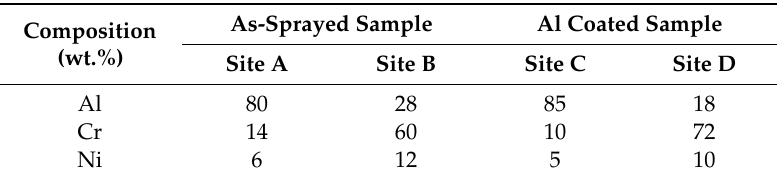
Figure 7. Cross-sectional morphology of bondcoat samples after oxidation for 200 h at 1200 ◦ C ( a ) as-sprayed sample, ( b ) Al coated sample; and EDX spectrum ( c ) point A, ( d ) point B, ( e ) point C, and ( f ) point D. Table 4. Compositions data measured by EDX on the cross-section of as-sprayed and Al coated NiCrAlY samples after oxidation for 200 h at 1200 ◦